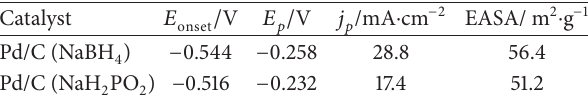
PO ) catalysts. 2 2